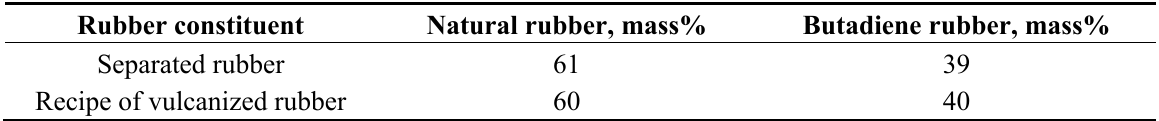
Table 12. Blend ratio of separated rubber from vulcanized rubber based on ISO 7270-2.